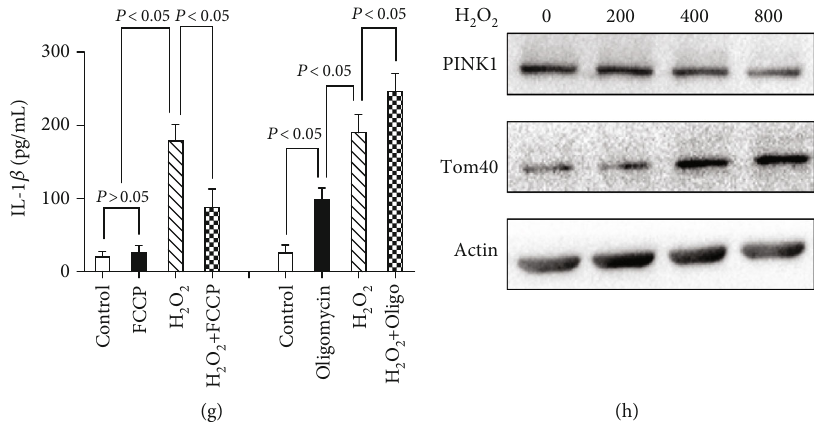
Figure 6: H O increases MMP and ROS and activates in fl ammatory responses in myocytes. Detection of MMP (a, c) and cellular oxidative 2 2 stress (b, d) in H O (0-400 μ M, 4 h) treated myocytes. Secretion of IL-1 β in myocytes treated by H 2 2 O (400 μ M, 4 h) together with NAC (10 mM) (f), FCCP (10 μ M) or oligomycin (10 μ M) (g). Western blot 1 β in myocytes treated by H 2 2 revealed the expression of PINK1 and Tom40 in myocytes treated by H